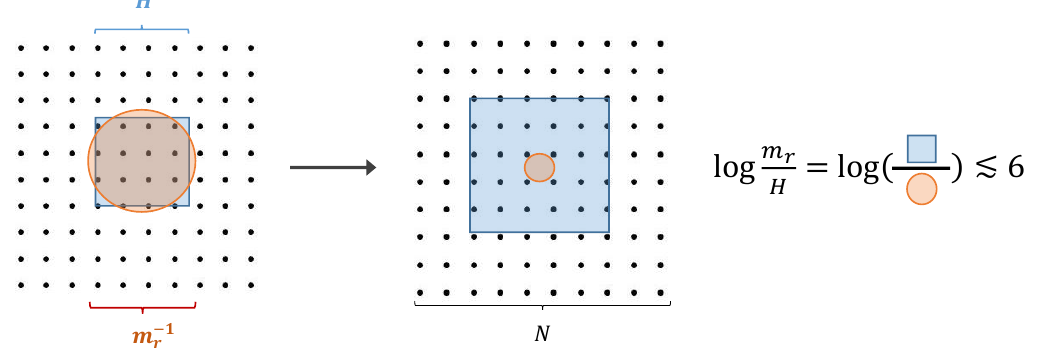
Figure 1 . An illustration of how the size of a string core, shaded red, and a Hubble volume, shaded blue, evolve relative to the lattice points in our simulations, where N is the number of lattice points in a spatial dimension. Requiring that the simulation contains at least a few Hubble volumes and that a string core contains at least (cid:24) 1 lattice point constrains the maximum scale separation that can be